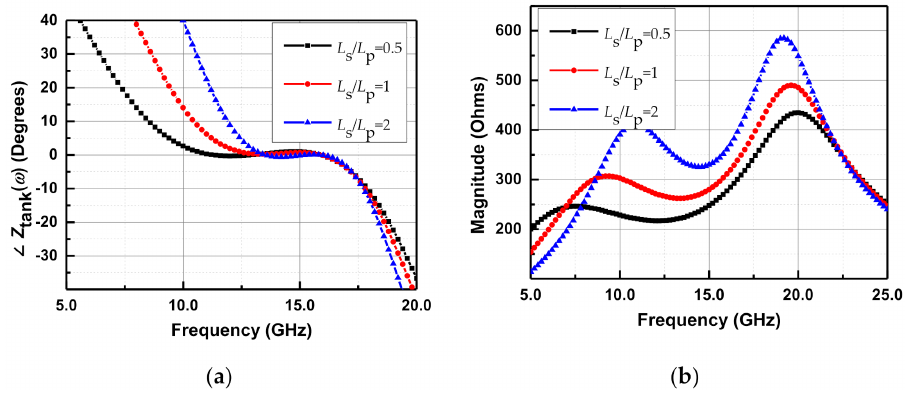
Figure 5. Simulated phase responses of the tank shown in Figure 3a, with L s / L p = 0.5, 1, and 2, respectively. ( a ) Phase response. ( b ) Magnitude response. Table 1. Parameter list for the tank shown in Figure